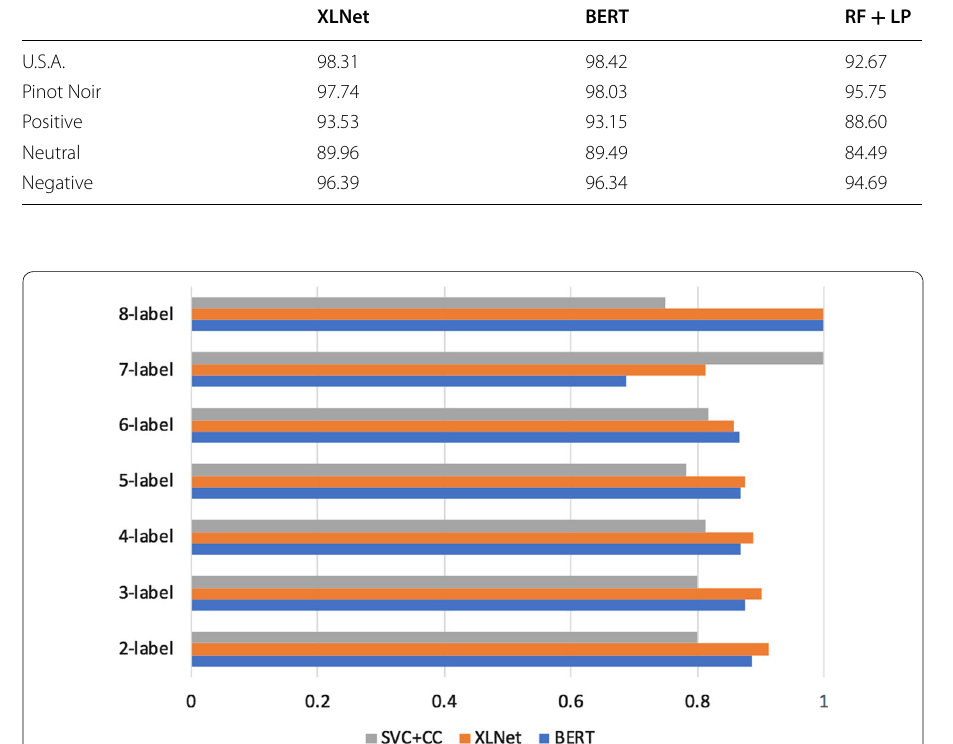
Fig. 6 The label group accuracy of RT